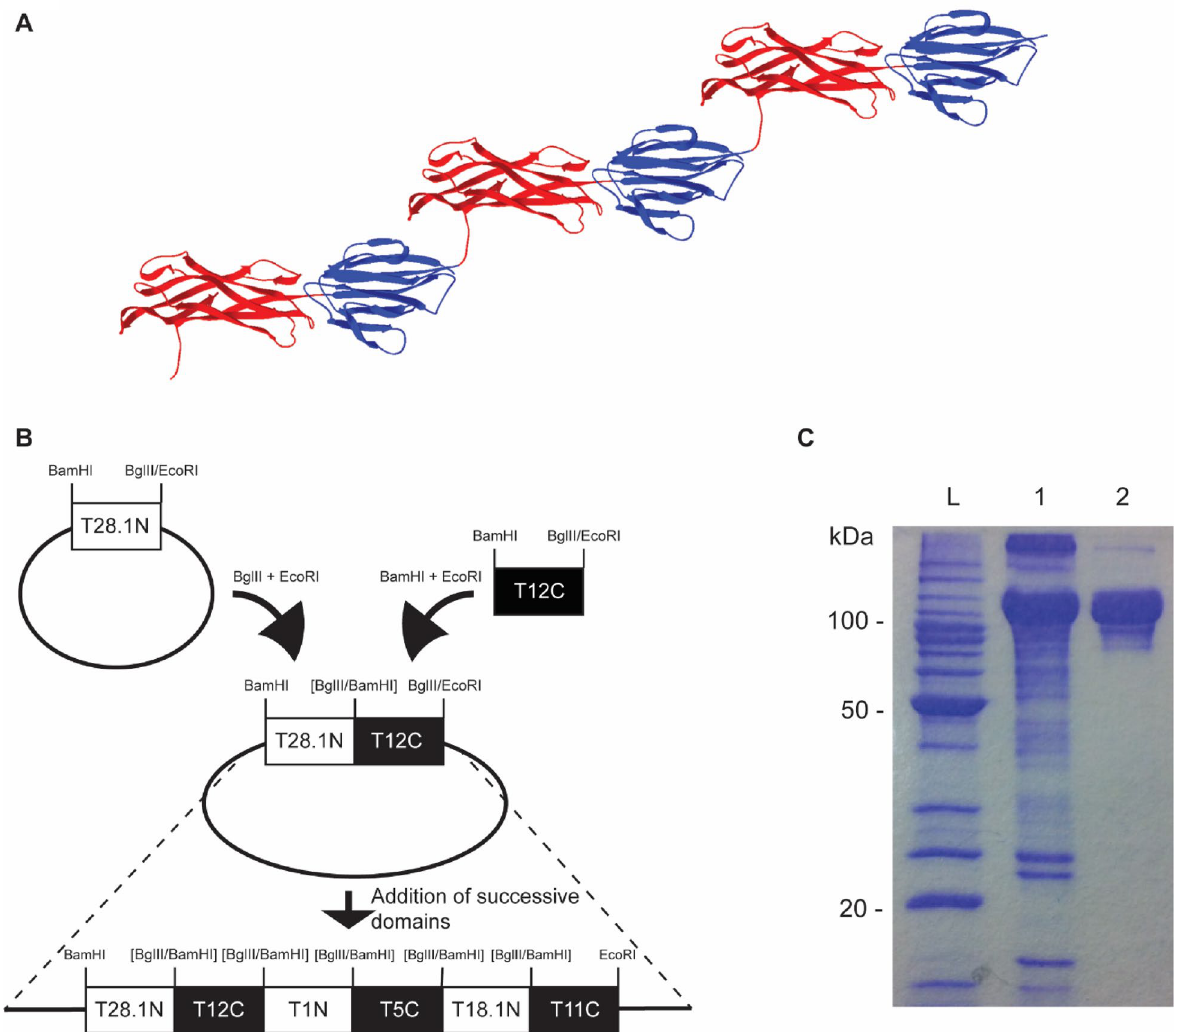
Figure 1. Construction of TeeVax1. ( A ) Structural model of TeeVax1 showing predicted N-terminal (red) and C-terminal (blue) domain fusions of six T-antigens. ( B ) Cloning strategy used to join successive T-antigen domains from different strains. Restriction sites in brackets denote irreversible ligation using compatible sticky ends. ( C ) 12.5% SDS-PAGE analysis of TeeVax1 stained with Coomassie blue dye. L = Benchmark protein ladder, 1 = After nickel-affinity chromatography, 2 = After size-exclusion